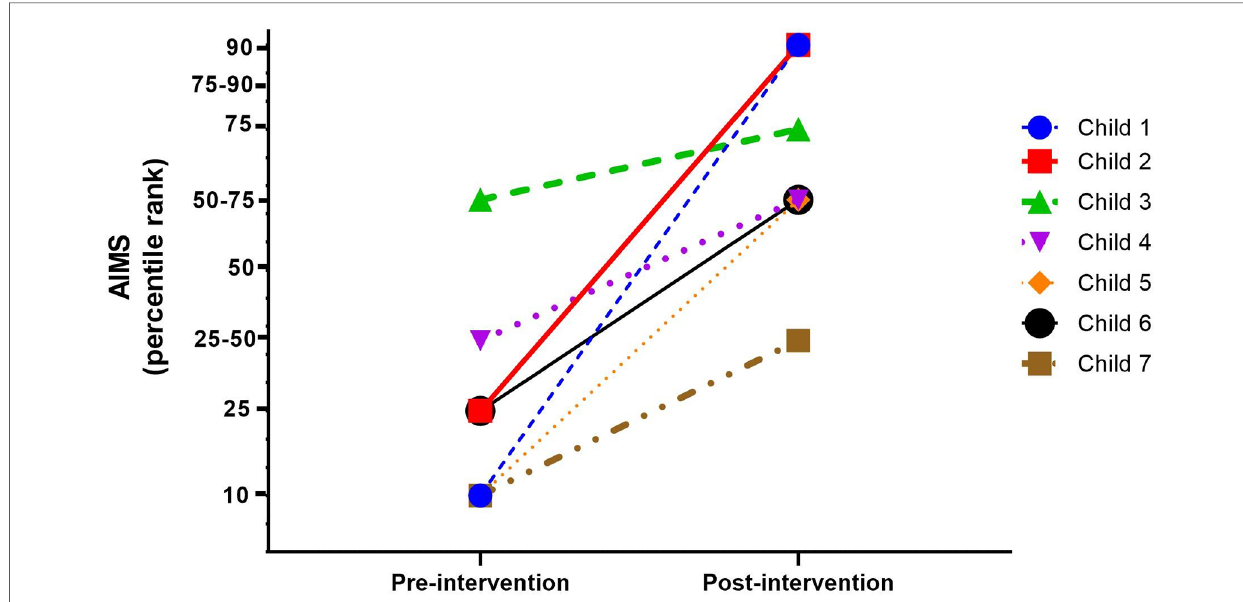
FIGURE 2 Developmental trajectories in percentile rank scores of the AIMS of the seven preterm infants before and after 8 weeks of COPCA intervention (results of the second Brazilian pilot